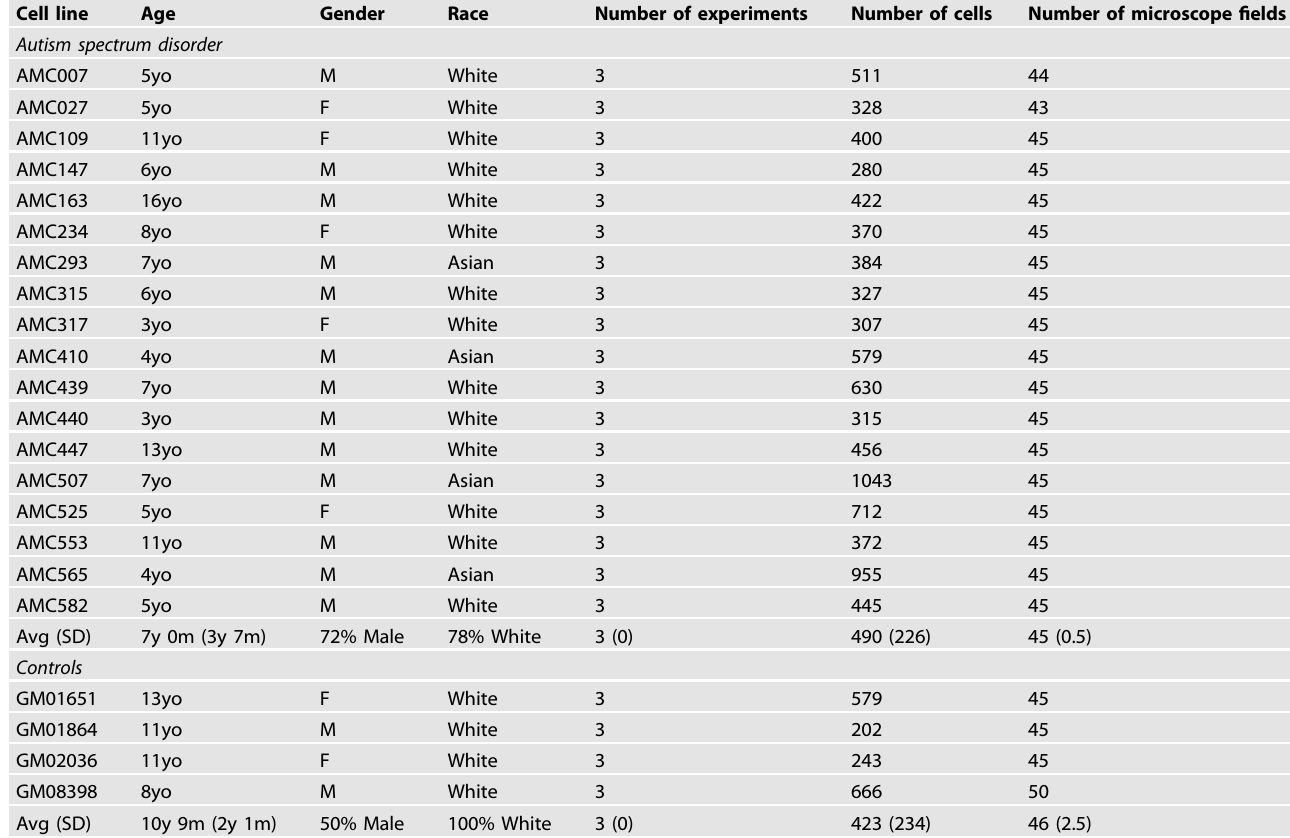
Table 1. Fibroblast Cell Lines